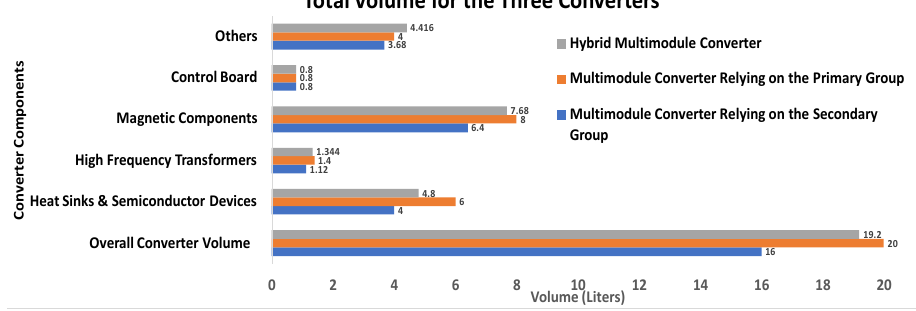
Figure 8. Converter components volume contribution in liters considering hard switching operation.